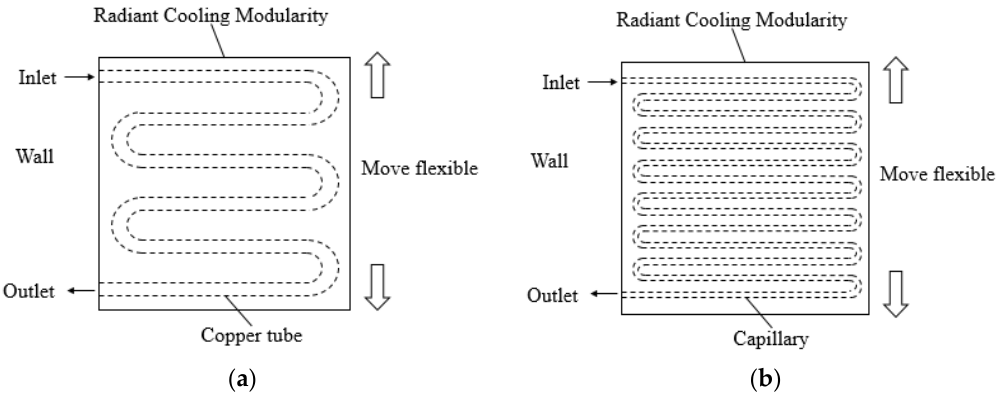
Figure 1. The schematic of the modular radiant terminal: ( a ) The copper tube module radiant terminal; ( b ) The capillary module radiant terminal.